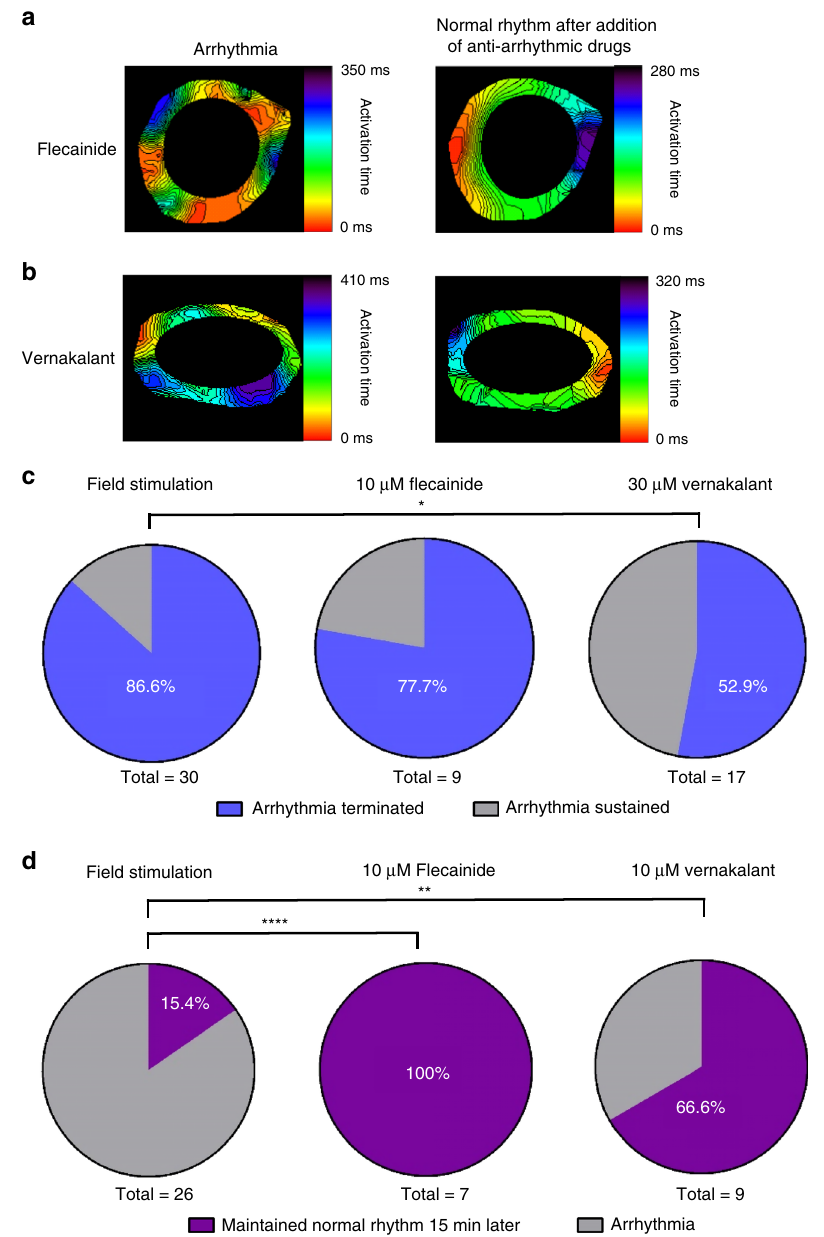
Fig. 5 Electrical and pharmacological cardioversion of atrial arrhythmias. a , b Activation maps of the arrhythmogenic atrial EHTs, during arrhythmia and after conversion to normal rhythm by 10 µ M fl ecainide ( a ) or 30 µ M vernakalant ( b ) treatments. c Percentage of successful arrhythmia termination in the atrial EHTs following fi eld stimulation ( n = 30, biologically independent samples) or the addition of 10 µ M fl ecainide ( n = 9, biologically independent samples) or 30 µ M verankalant ( n = 17, biologically independent samples). * p < 0.05, Fisher test. d Success rate (%) in maintaining normal rhythm at 15 min after cardioversion without any treatment ( n = 26, biologically independent samples), with fl ecainide treatment ( n = 7, biologically independent samples) and with verankalant treatment ( n = 9, biologically independent samples). ** p < 0.01, **** p < 0.0001, Fisher